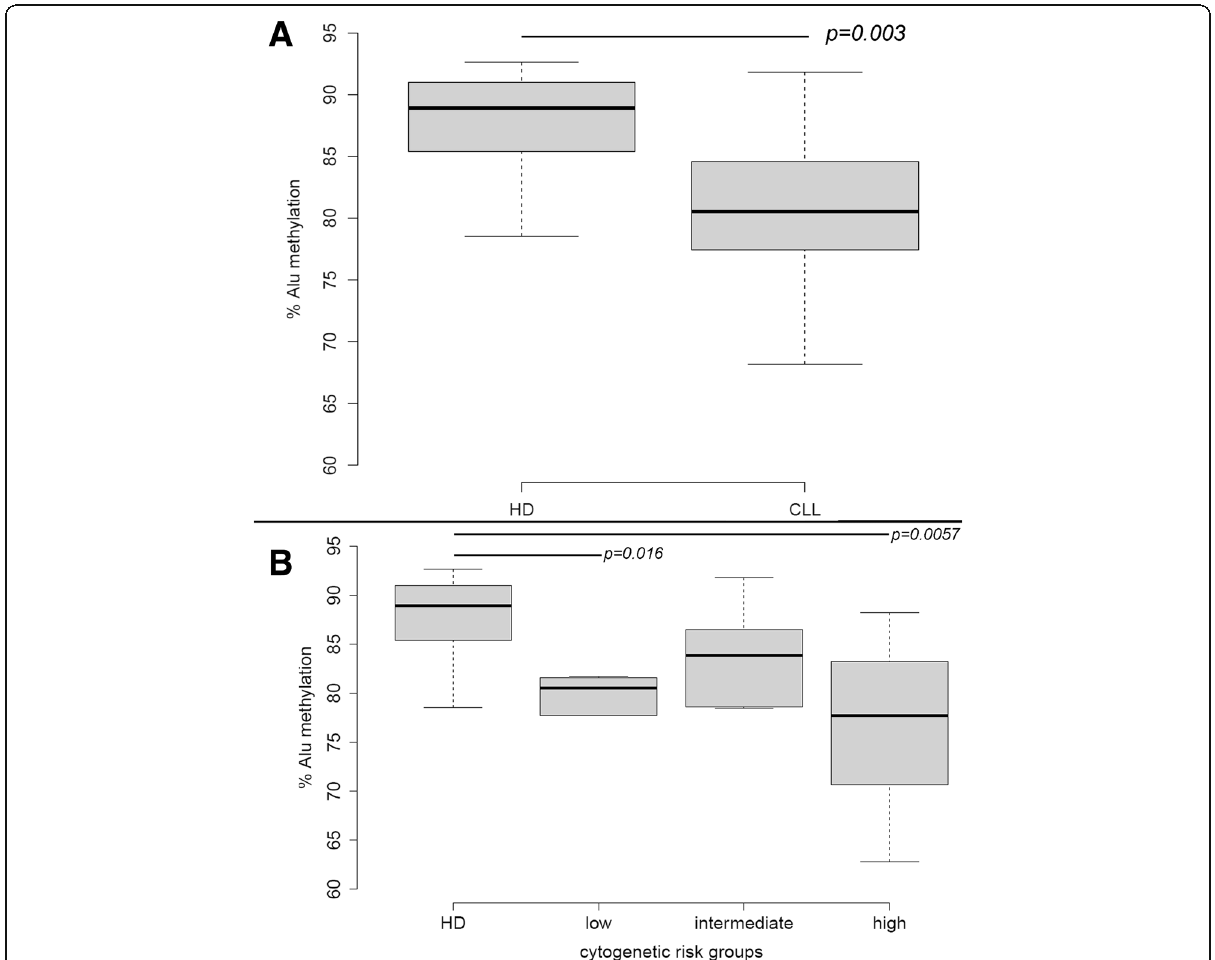
Fig. 2 Alu methylation analysis in CLL patients. a Alu methylation level in CLL patients compared with HD, and ( b ) in relation to different cytogenetic risk groups according to the karyotypic alterations identified by FISH. Only the statistically significant differences ( p <0.05) are indicated. HD, healthy donor; CLL, chronic lymphocytic